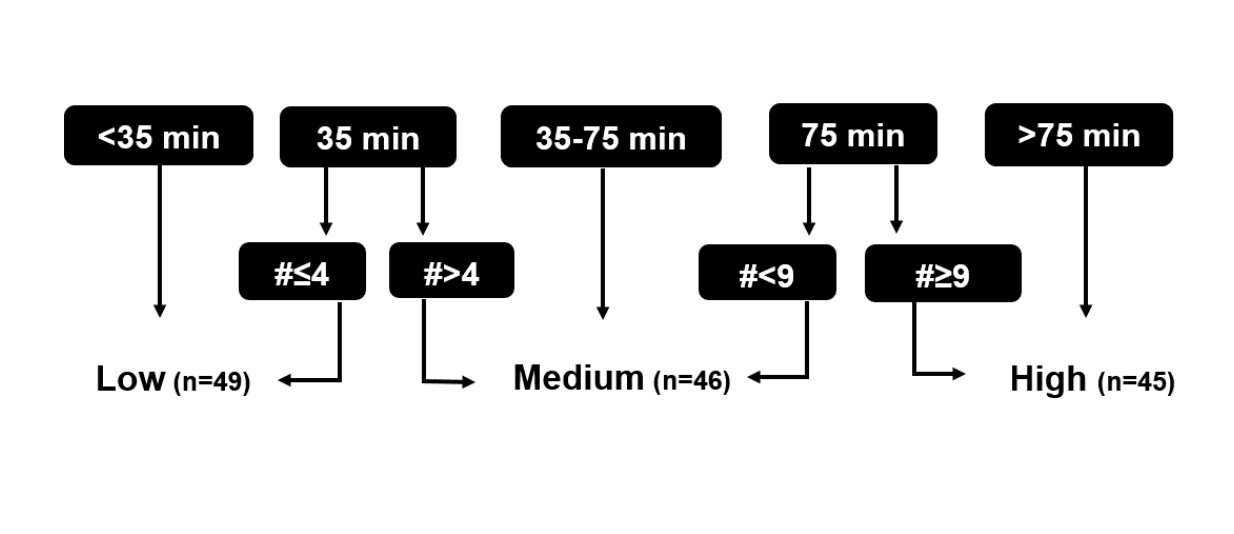
Figure 2. Division (into 3 groups) of patients based on total duration and number of contacts between patients and coach. Min=minutes; #=number of contacts; n=number of patients in each